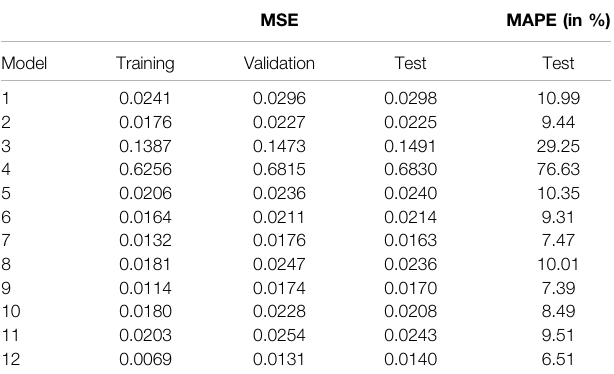
TABLE 5| Errormeasures fortheprediction of κ viaANNs, whereMSEisgivenfor thetraining, validation and testsets,and MAPEforthetestset.Note thatMSE is evaluated on the logit scale and MAPE on the linear scale.